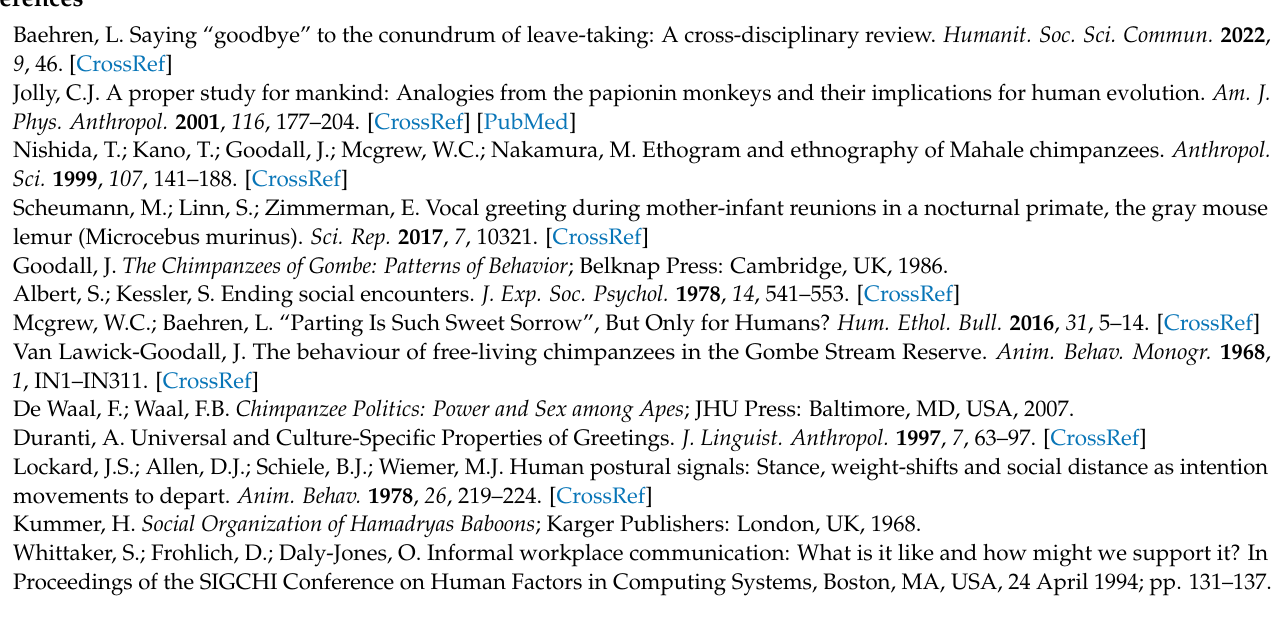
models; Figure S2: Cook’s distance for all regression models; Figure S3: DFFITS for regression models; Figure S4: Half-normal plots for frequency models; Table S1: Pseudo-maximised log-likelihood values (plogLik), degrees of freedom (df), and pseudo-Akaike (pAIC) and Bayesian (pBIC) information criteria by structure; Table S2: Wald statistics (Wa), degrees of freedom (df), and p values for each